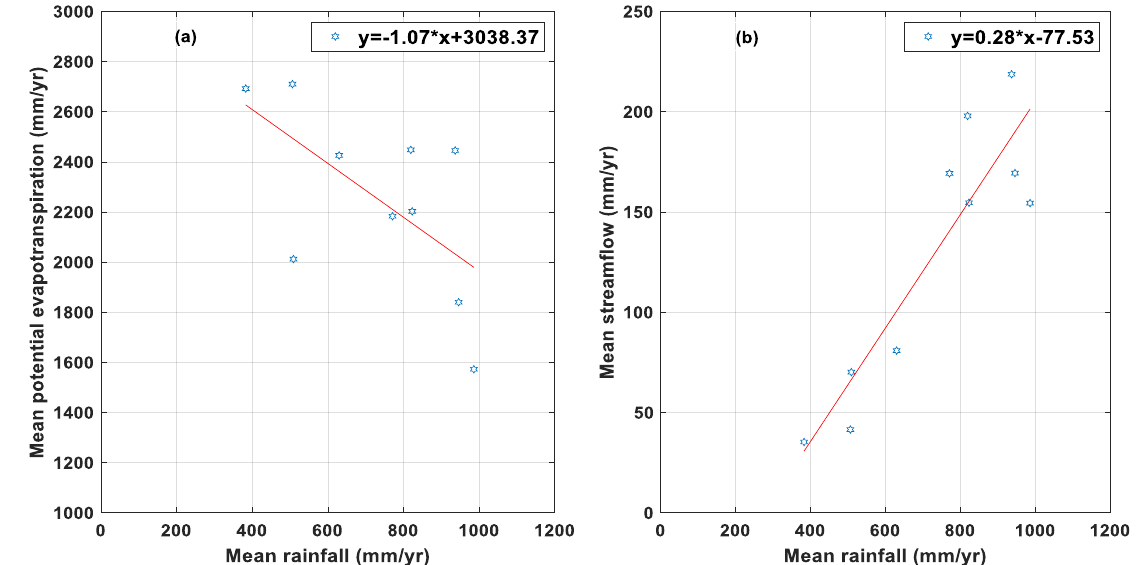
Figure 6. ( a ) Mean potential evapotranspiration (PET) versus mean rainfall (mean RF); ( b ) mean streamflow (Q mean ) versus mean rainfall for the 10 watersheds in the basin.